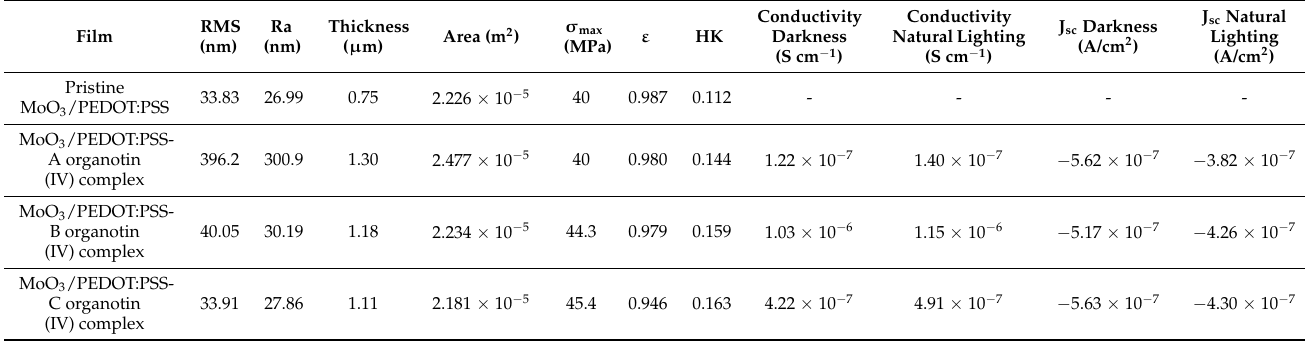
Table 1. Roughness, mechanical and electrical parameters of the hybrid